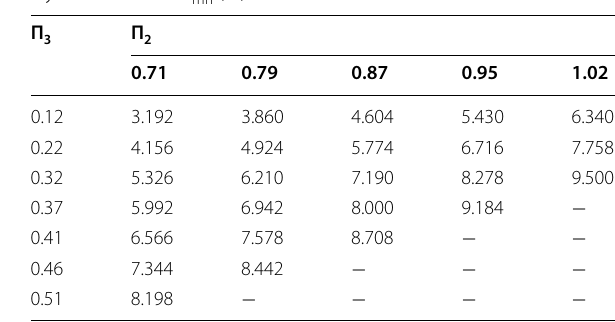
Table 3 Orthogonal simulation results of equivalent neutral